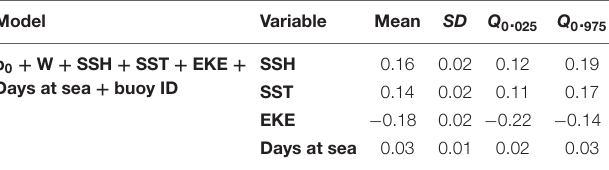
TABLE 3 | Numerical summary of the marginal posterior distribution of the fixed effects for the best tuna B-HSMs